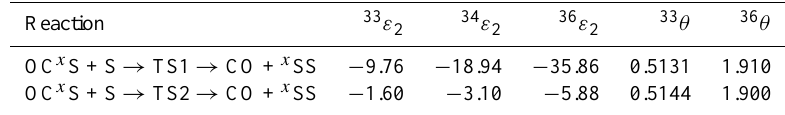
Table 2. Kinetic isotope effects for sulfur abstraction reactions estimated by the transition state